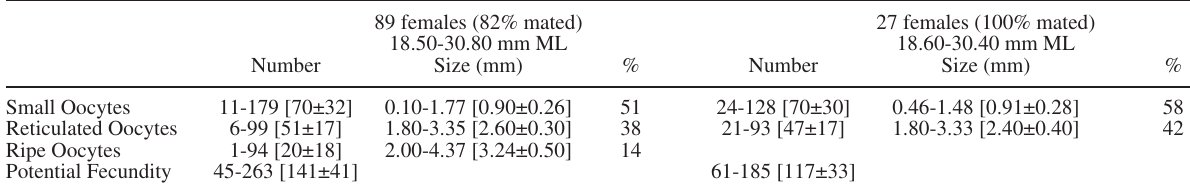
Table 2. – Sepietta oweniana from the Sardinian waters: number, size and % of the oocytes observed in the ovaries of two groups of mature females. In brackets mean values ±